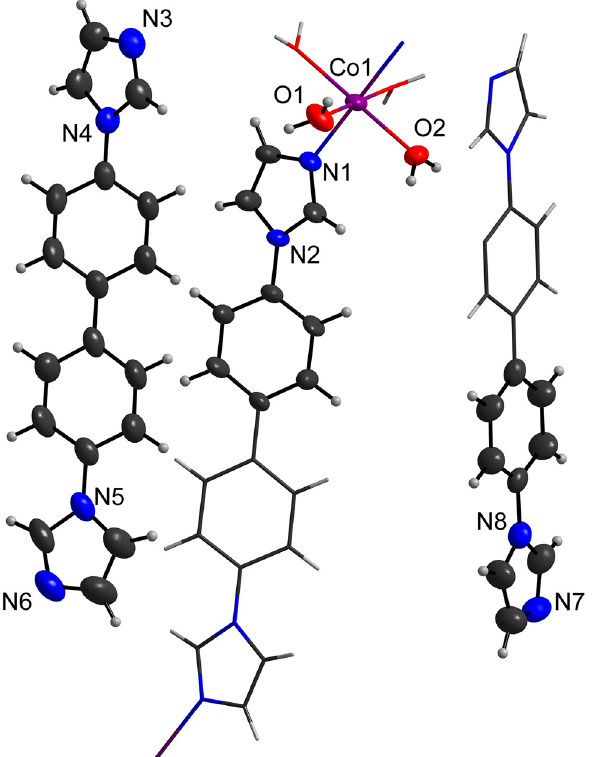
Table 1 contains crystallographic data and Table 2 contains the list of the atoms including atomic coordinates and displacement parameters.